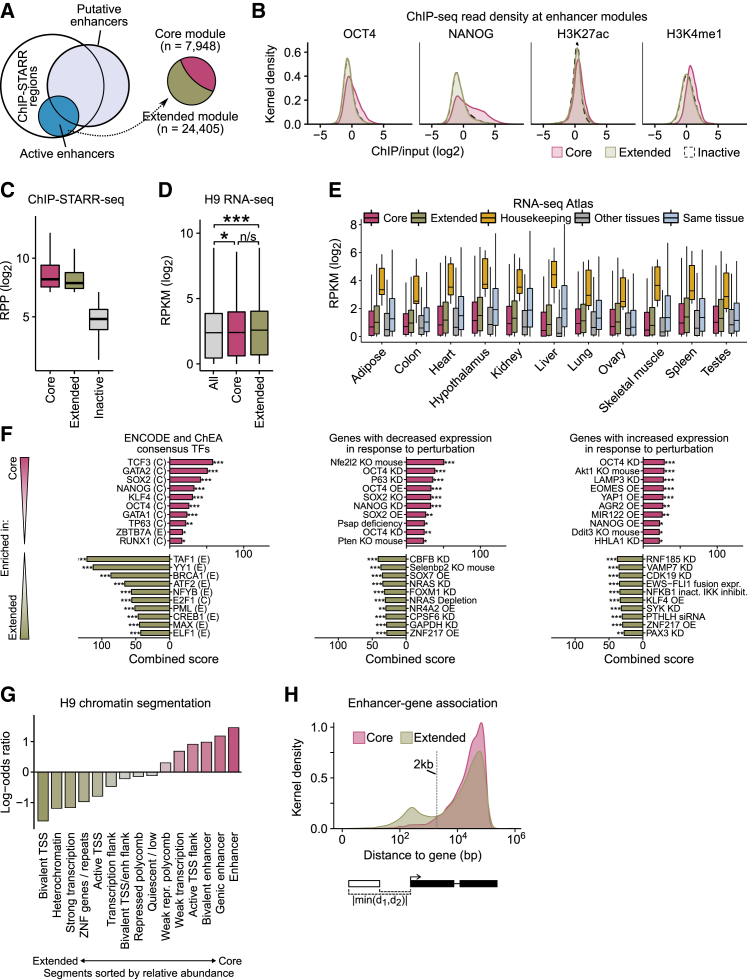
Active Enhancers Include Core and Extended ESC-Enhancer Modules(A) The overlap between published putative enhancers (Hawkins et al., 2011, Rada-Iglesias et al., 2011, Xie et al., 2013) (light blue) and regions assessed by ChIP-STARR-seq (white) or called active (RPP ≥ 138; blue). We refer to ChIP-STARR-seq enhancers overlapping published putative enhancers as the “core module” and non-overlapping regions as the “extended module.”(B) Kernel density plots of the distribution of enrichment values in ESCs for the indicated factor for peaks associated with the core or extended modules or for inactive regions.(C) RPP values for all assessed genomic regions compared to enhancers from the core or extended modules. Boxes are IQR; line is median; and whiskers extend to 1.5× the IQR.(D) RNA-seq in H9 (Takashima et al., 2014) for all genes compared to genes associated with either core or extended enhancer modules. Boxes like in (C). RPKM, reads per kilobase million. ∗ p < 0.05; ∗∗∗ p < 0.001 (t test).(E) Gene expression in tissues from the RNA-seq Atlas (Krupp et al., 2012) for all genes linked to the core or extended modules. Housekeeping (Eisenberg and Levanon, 2013) and tissue-specific genes (Lachmann et al., 2018) are also shown. Tissue-specific genes are split into the one indicated (same; x axis) or “other tissues.” As no tissue-specific gene set was available for hypothalamus, whole-brain-specific genes were used. Boxes like in D.(F) Enrichment analysis (Enrichr) testing genes associated with the core (top) and extended (bottom) modules. Top-10 results for TF binding sites from ENCODE and ChEA (left) and genes downregulated (middle) or upregulated (right) upon single-gene perturbations from GEO.(G) Relative enrichment (log-odds ratio in ESCs compared to all) of H9 chromatin segments (Kundaje et al., 2015) in core and extended module enhancers.(H) Kernel density plot of the distance to associated genes for core and extended module enhancers. Shortest distance from either enhancer region boundary was recorded.